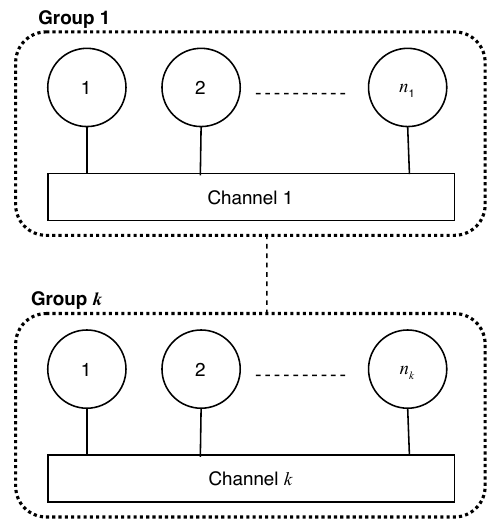
Figure 1. Distributed system overview with anonymous processes assigned to k